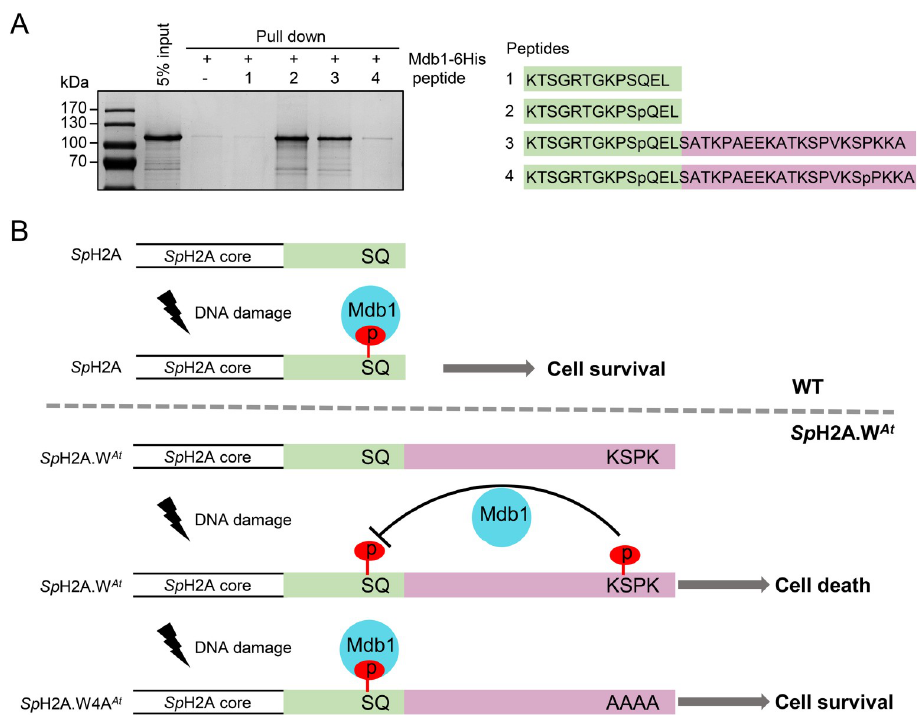
Fig 6. KSPK motif directly interferes with binding of Mdb1 to phosphorylated SQ in a phosphorylation dependent manner. (A) Mdb1 recombinant protein was expressed in E . coli BL21 and purified using Ni-NTA beads. Biotinylated peptides, as depicted on the right, corresponding to C terminus of Sp H2A, with unmodified (SQ) or S129 phosphorylation (SpQ), or SpQ with unmodified KSPK motif (SpQ+KSPK) or SpQ with S145 phosphorylation (SpQ +KSpPK), were incubated with streptavidin Dynabeads and Mdb1 recombinant protein. The eluates were analyzed by SDS-PAGE with Coomassie staining. (B) The model of crosstalk between SQ and KSPK phosphorylation. In WT cell, S129 phosphorylation site recruit Mdb1 as platform for downstream DDR in response to DNA damage. In Sp H2A.W At cell, KSPK phosphorylation prevents the Mdb1 binding to SQ phosphorylation site, thus DNA cannot repair properly. In Sp H2A.W4A At cell, the absence of KSPK phosphorylation allowed the Mdb1 binding to phosphorylated SQ to recruit DDR for DNA repair.